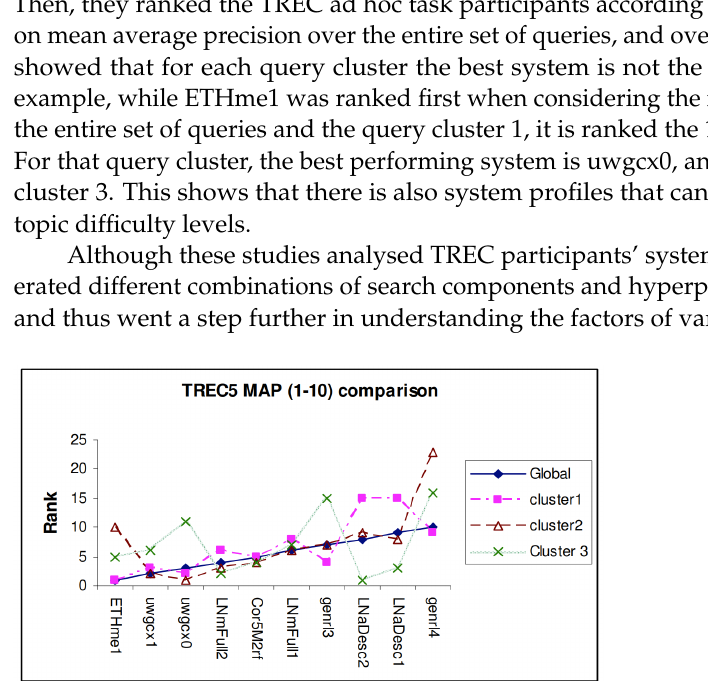
Figure 10. The first ranked system differs according to the query clusters. The rank of the system is on the Y-axis and the system is on X-axis. Blue diamonds correspond to the ranks of the systems when considering all the queries, pink squares when considering the query cluster 1, brown triangles are for query cluster 2, and green crosses for cluster 3. Systems on the X-axis are ordered according to decreasing effectiveness on average on the query set. Figure reprinted with permission from [45], Copyright 2007, Kompaore et